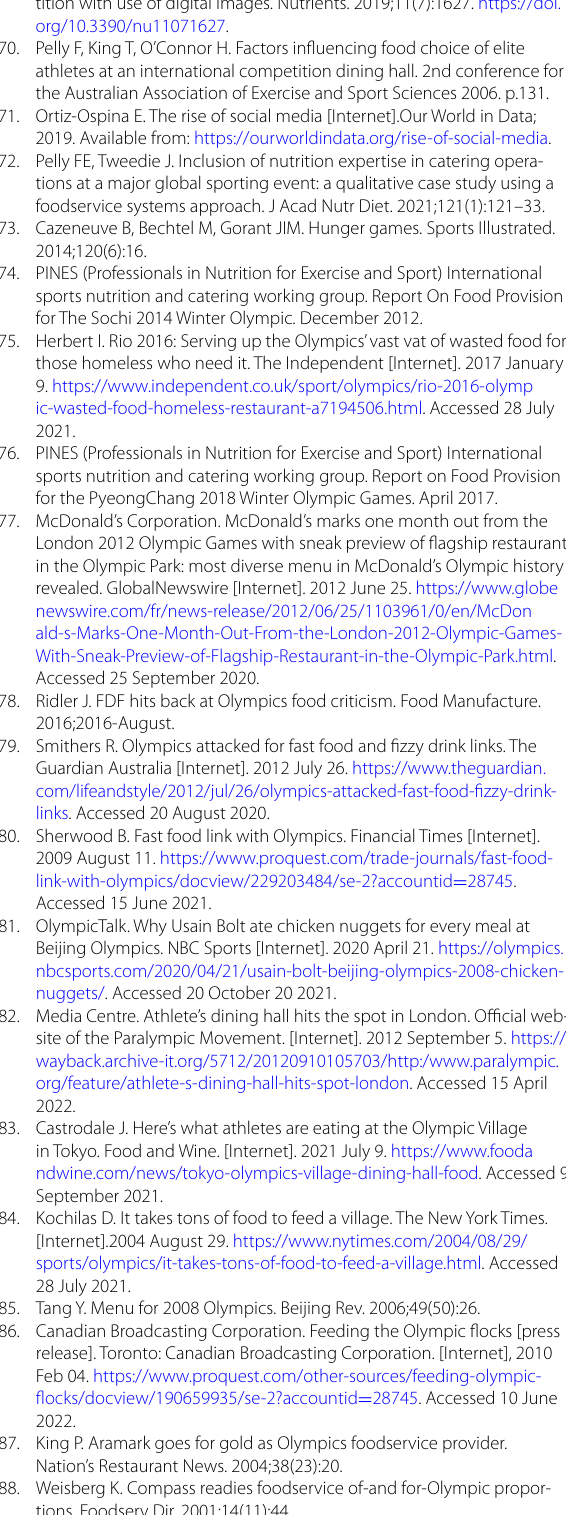
47. Olympic Winter Games. Organizing Committee. Official report of the Olympic Winter Games Torino 2006. Torino, Italy; 2007. 48. Beijing Organising Committee for the Games of the XXIX Olympiad. The official report of the Beijing 2008 Olympic Games Beijing; 2008. 49. Olympic Winter Games Organizing Committee. Official report of the Olympic Winter Games Vancouver 2010. Vancouver, Canada; 2010. 50. Summer Olympic Games Organizing Committee. Official report of the Summer Olympic Games London 2012. London, UK; 2013. 51. Olympic Winter Games. Organizing Committee. Official report of the Olympic Winter Games Sochi 2014. Sochi, Russia; 2015. 52. Olympic Winter Games. Organizing Committee. Official report of the PyeongChang 2018 Olympic and Paralympic Winter Games. Pyeo- ngChang, South Korea; 2019. 53. London Organising Committee for the Olympic Games and Paralym- pic Games Ltd. Food vision for the London 2012 Olympic Games and Paralympic Games; 2009. 54. Organising Committee for the Olympic and Paralympic Games in Rio in 2016. Rio 2016: Taste of the Games. Rio de Janeiro, Brazil; 2014. 55. The Tokyo Organising Committee of the Olympic and Paralympic Games. Basic strategy for food and beverage services: Tokyo